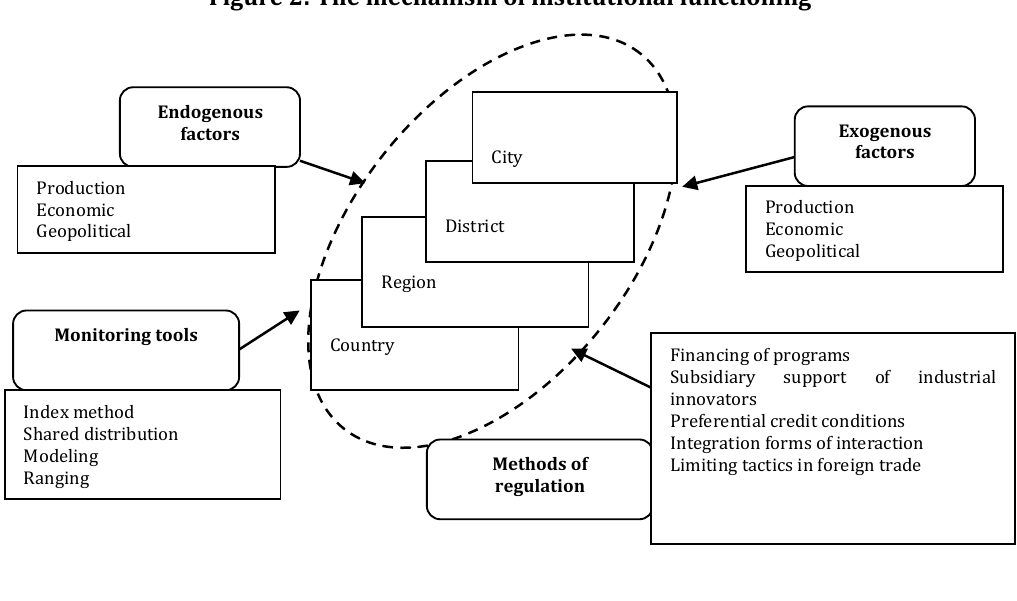
Figure 2: The mechanism of institutional